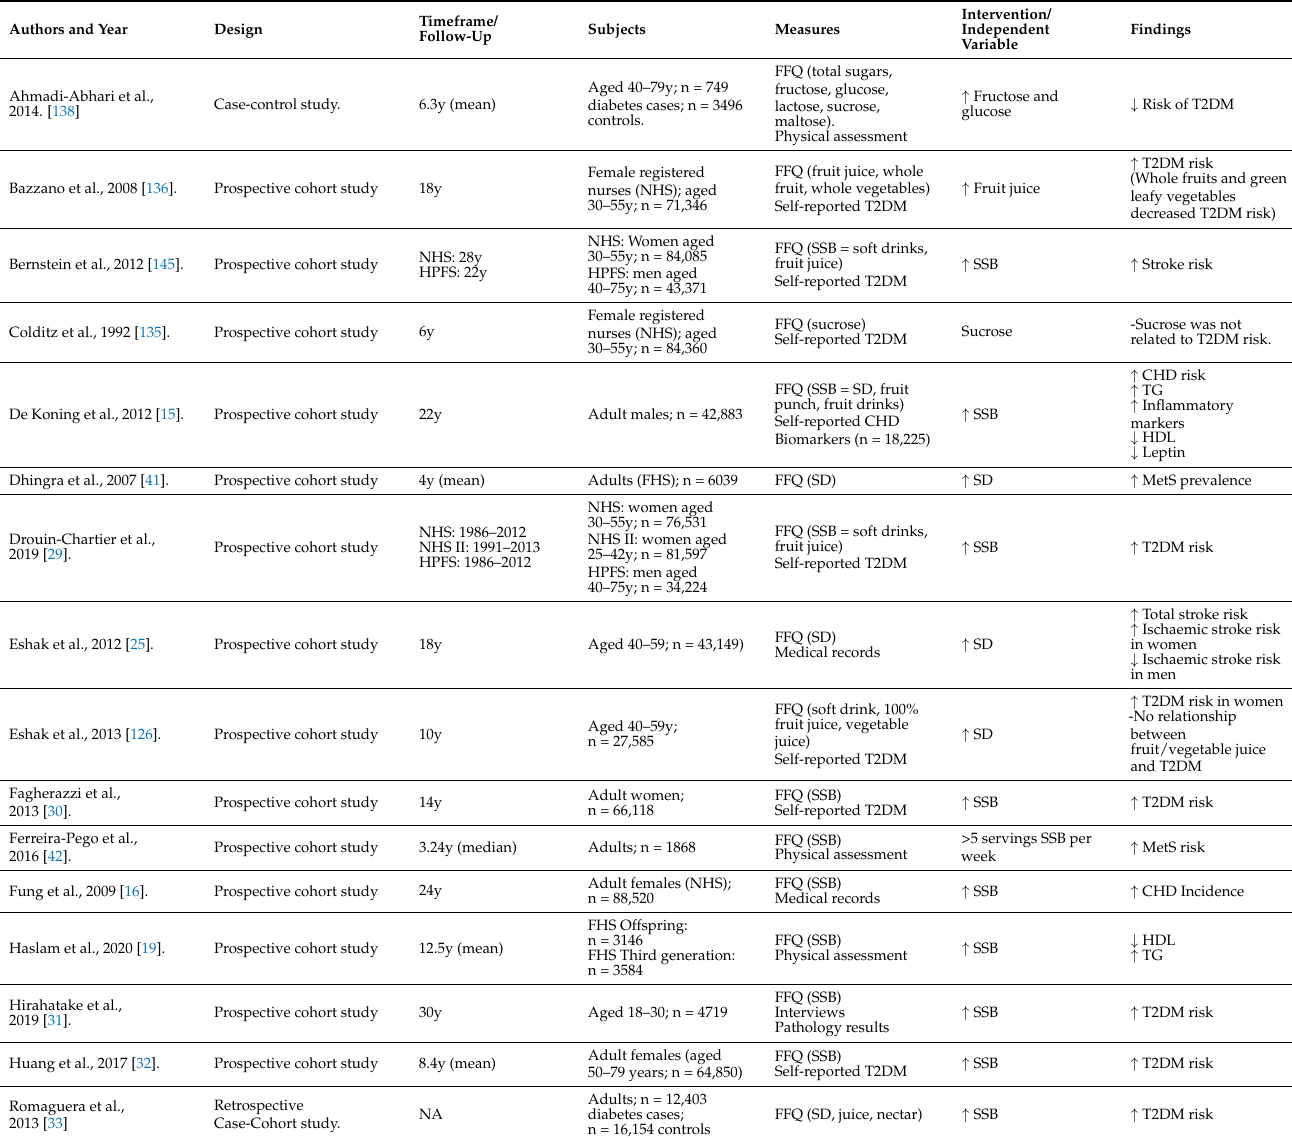
Table 2. Findings from published reports on the effects of free or added sugars on chronic disease in human